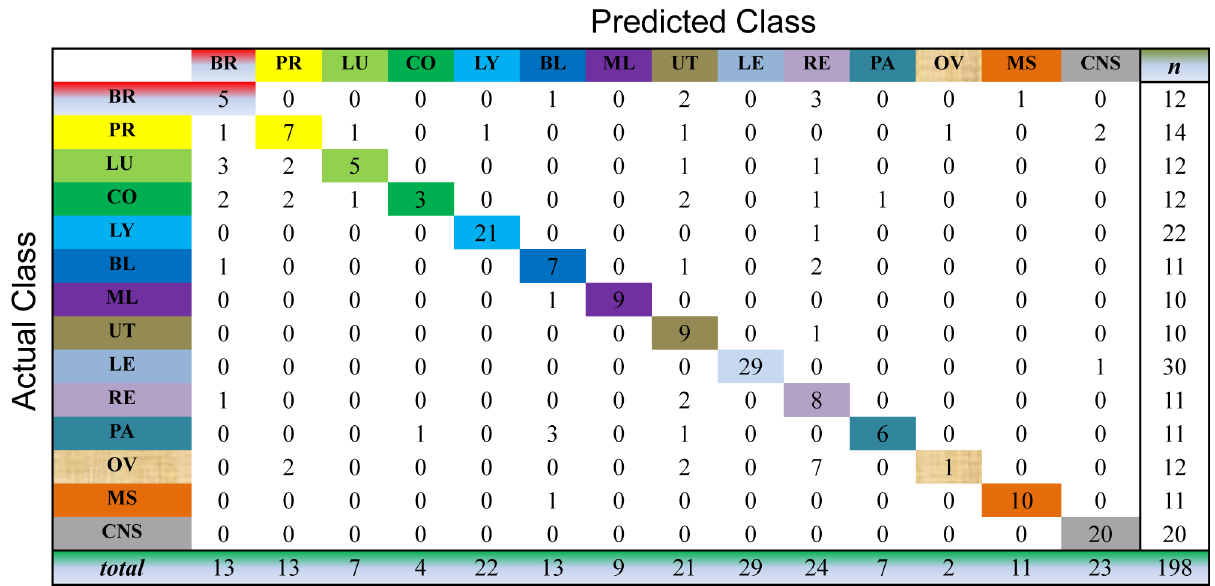
Fig 3. Confusion matrix of prediction results using Semi-PNMF, which achieves a total accuracy of 70.71%. Matrix delineates distribution of actual compared with predicted class membership for multiclass cancer prediction on the GCM dataset.